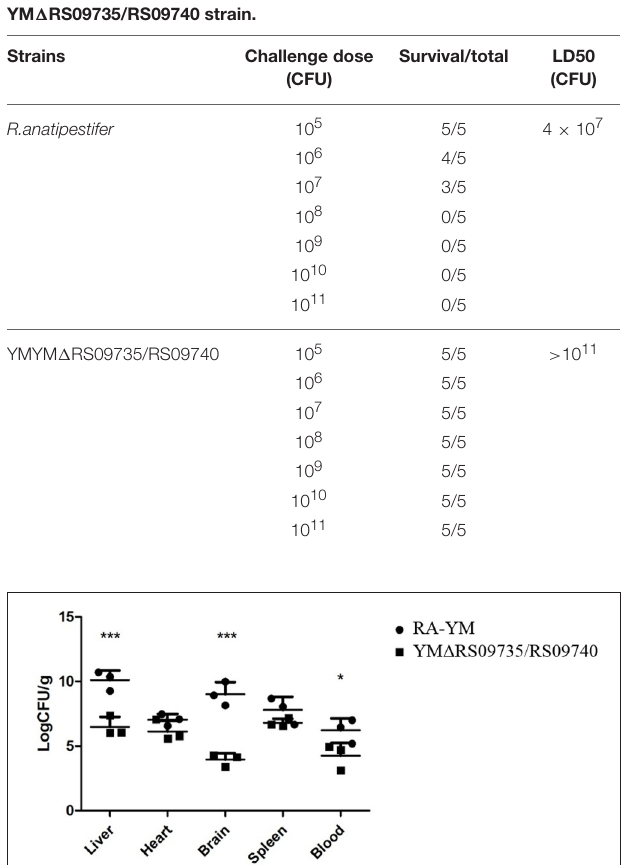
TABLE 3 | Virulence of the wild-type R. anatipestifer YM and YM 1 RS09735/RS09740 strain. Strains Challenge dose